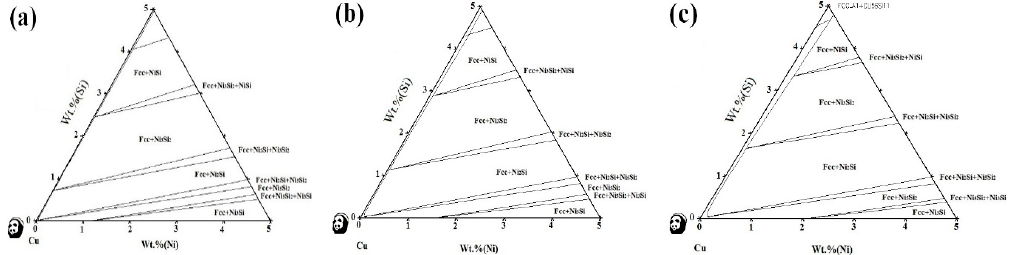
Figure 1. Cu-rich isothermal section of the Cu-Ni-Si ternary alloy ( a ) 450 °C. ( b ) 500 °C. ( c ) 550 °C.